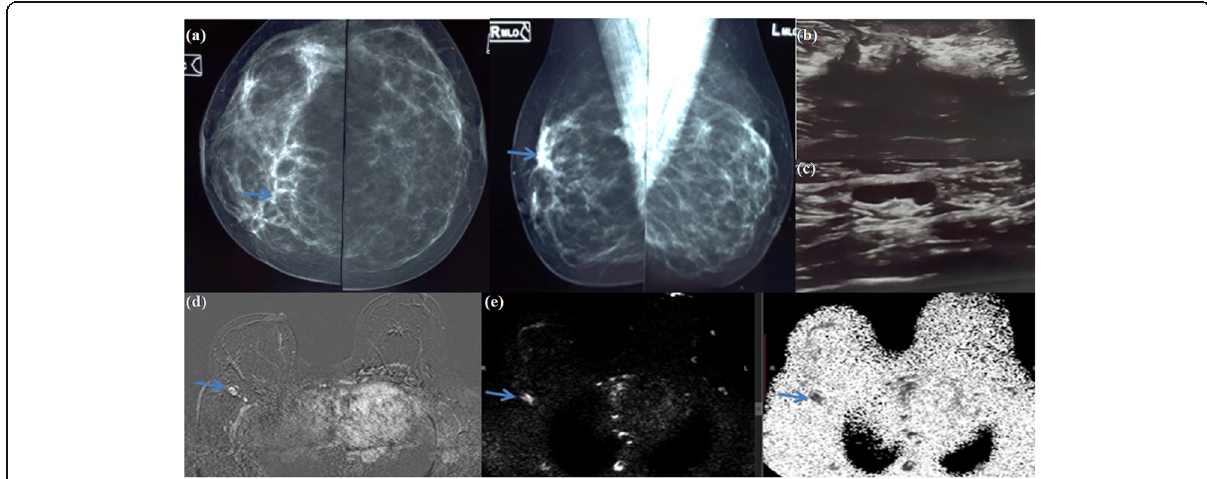
Fig. 7 A case with right breast multicentic malignant lesions, received neoadjuvant chemotherapy with pathologically proven completely burnt out tumor (complete pathological response). a Post-neoadjuvant chemotherapy mammography revealed UIQ architectural distortion. b Ultrasound showed multiple masses seen extending from right 11 to 2 o ’ clock position of ill-defined outline and distortion located at 1 o ’ clock. c Right indeterminate axillary LN with increased cortical thickness was also seen. d DCE-MRI showed no sizable gross enhancing masses, yet a pathologically enlarged right axillary lymph node with prominent cortex was noted. e Showing restricted diffusion on the DWI-MRI. In this case, the findings of DCE-MRI and DWI-MRI were correlating with the pathological specimen results regarding the tumor and axillary LNs, while SM gave a false positive result of the mass